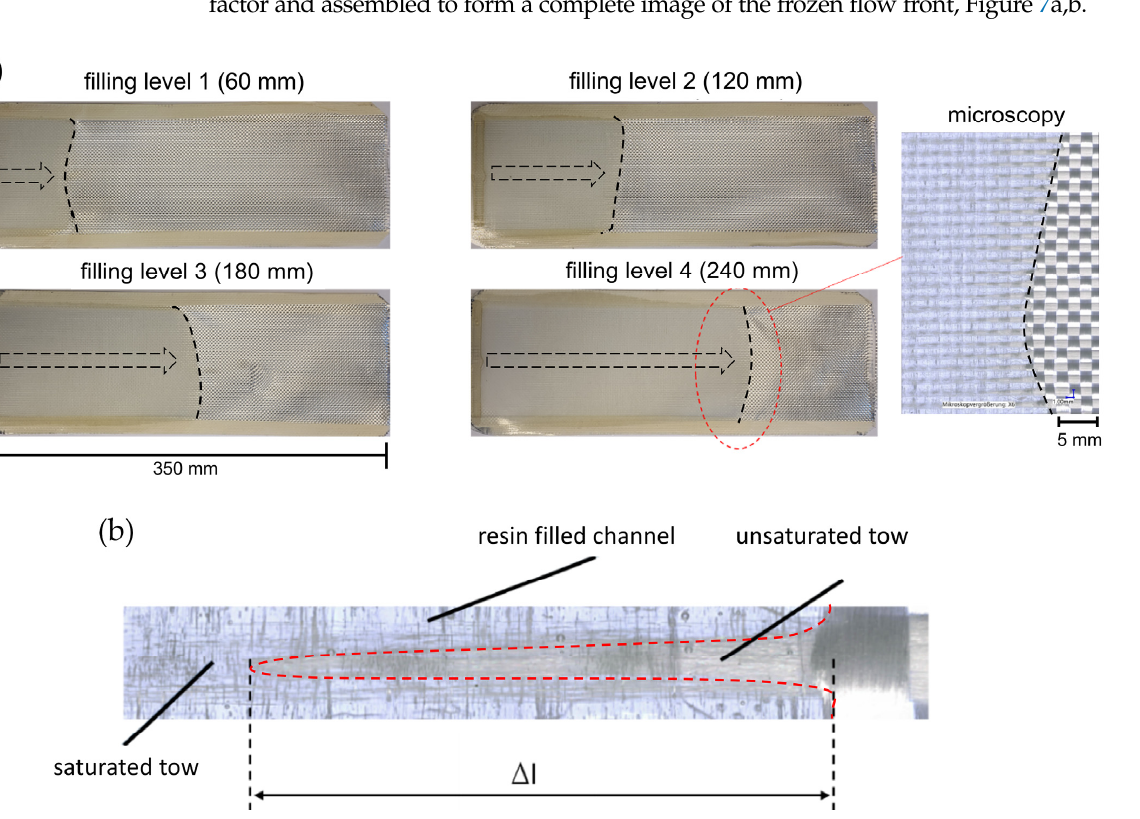
Figure 8. Flow path difference along the mold sections. The existing scatter is mainly attributed to fluctuations in permeability caused by the manual insertion of the fabrics into the cavity, since the manual preparation of the pre- forms may result in local displacements of the tows, and thusly produce irregular gaps and fiber distributions. The injection pressure has a considerable influence on the flow velocity and thus on the locally prevailing capillary number. Contrary to what was calculated by Godbole [24], the results averaged per experiment show the proportionality of the flow path difference